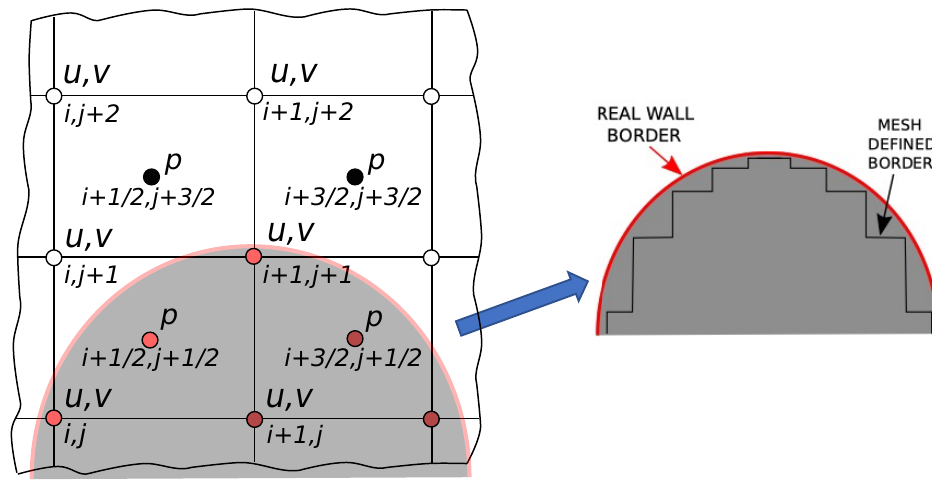
Figure 1. Half-staggered computational mesh with a region with the red nodes belonging to the solid body. The figure on the right shows how the solid curved wall is seen on the